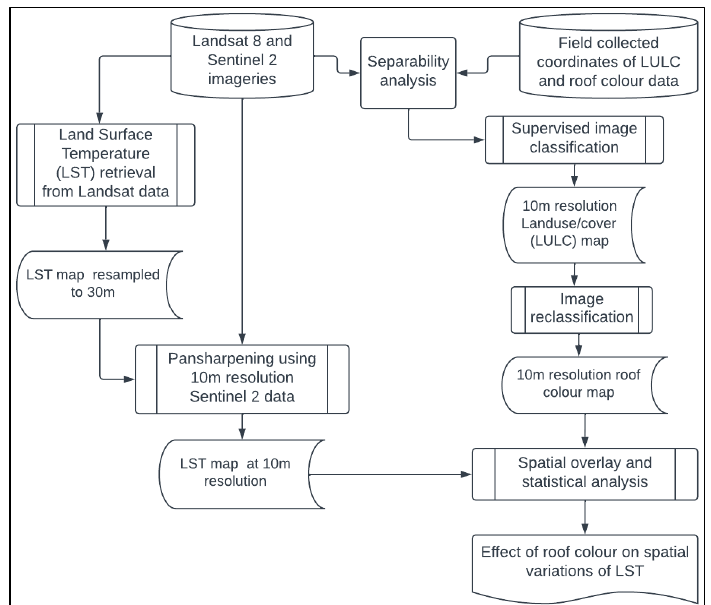
Figure 2. Summary of steps followed in the study .